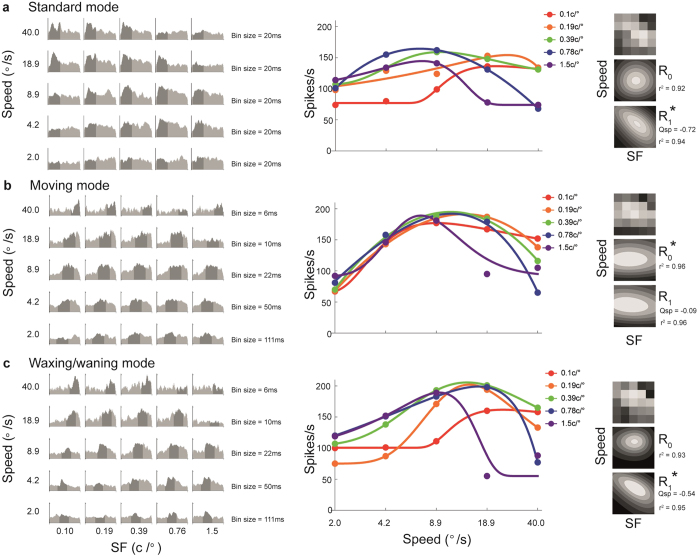
Data from a MT neuron that was speed-tuned only in the moving mode.Rows show responses to the (a) standard, (b) moving and (c) waxing/waning modes. For each panel, the first column shows the responses to each SF-speed combination as a peri-stimulus time histogram (PSTH). In these histograms, bin sizes (indicated at the right hand side of each row) were adjusted to represent equal distances travelled by the stimulus in the moving mode. The y-axis represents the response-rate calculated within the bins; scale is the same for all histograms, with the maximal value of 266Hz. The shaded regions represent the time intervals during which the response rates shown in the second and the third column were calculated. The second column displays speed-tuning curves obtained using Gabor patches of different SF. The circles represent the measured response rates, and the curves are fitted skewed log-Gaussian functions. The third column illustrates tuning surfaces describing the responses to the 5 × 5 matrices of conditions (top) and the surfaces were fitted to two models, R0 (middle) and R1 (bottom). The models that provided the better fits, as determined by P(R0|R0, R1), are indicated by asterisks. The quality of fit (r2) and the estimated Qsp are also provided.